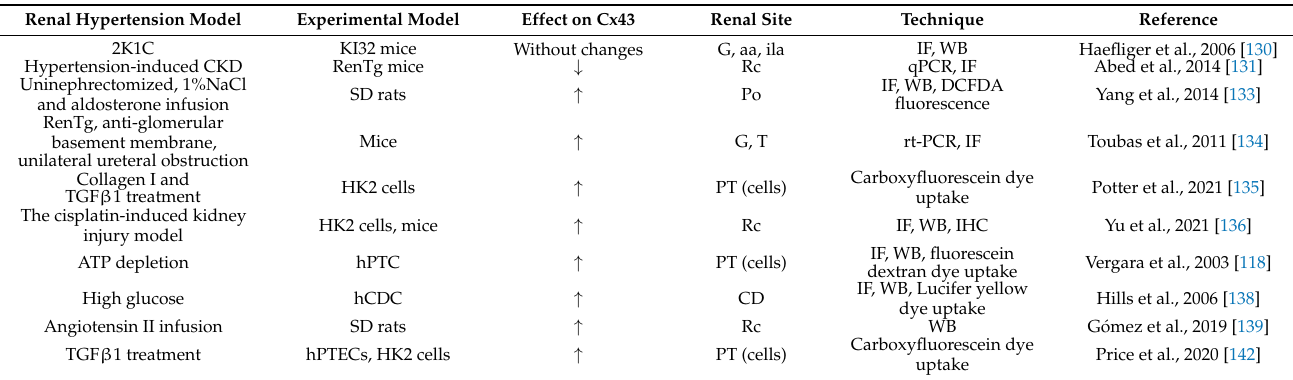
Table 1. Connexin 43 in hypertensive